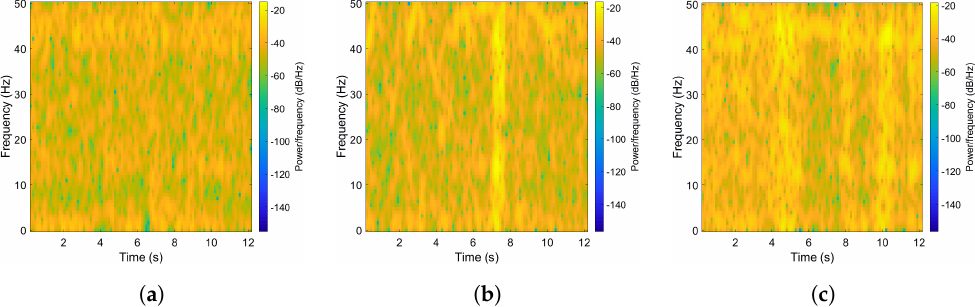
Figure 6. Plots of the STFT of acceleration frames for different road pavement conditions. ( a ) Good pavement condition; ( b ) Pothole distress; ( c ) Fatigue cracking distress.